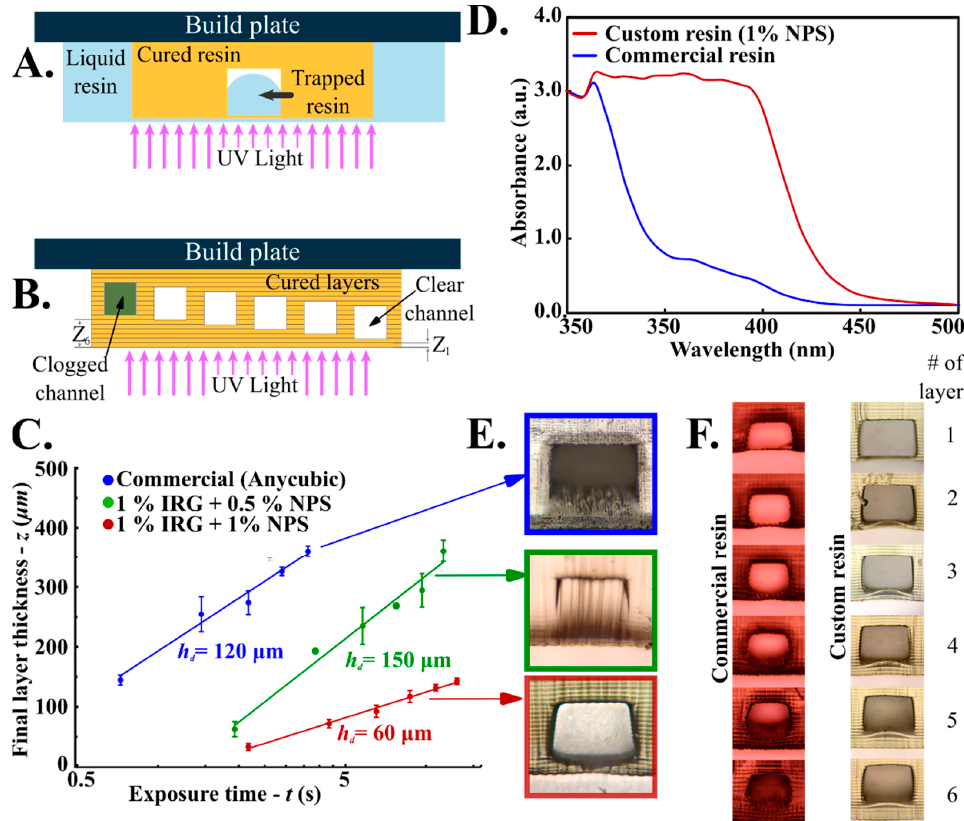
Figure 3. Schematic illustrating ( A ). trapped liquid resin in an embedded channel and ( B ). curing of the trapped resin due to multiple UV exposure cycles. ( C ). Log-linear plot for exposure time (t) vs final layer thickness (z) for commercially available and custom resin formulations. ( D ). UV/Vis spectra of commercial and custom resin formulation with 1% NPS. ( E ). Microscopic images of 300 micron square channel cross-section printed with commercial resin with h d = 120 μ m (blue box, partially clogged), custom resin with low UV blocker composition with h d = 150 μ m (green box, fully clogged) and custom resin with high UV blocker composition with h d = 60 μ m (red box, clear). ( F ) Intermediate images of the microfluidic channel cross-section (for 300 μ m square channel) after curing of each successive layer to seal the channel using both commercial and custom resins.